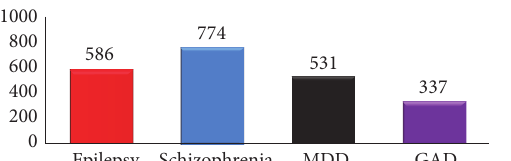
Figure 2: Distribution of respondents’ recognition of mental illness among residents of Gimbi town, 2014.